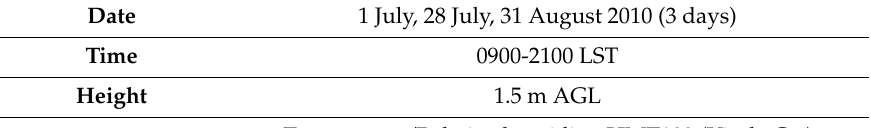
Figure 2. Equipment for the mobile observation. ( a ) A double tube with a cooling fan; ( b ) Arrangement of the instruments on a bicycle. Table 1. Outline and instruments of mobile observation. Table 2. Outline and instruments of stationary observation at